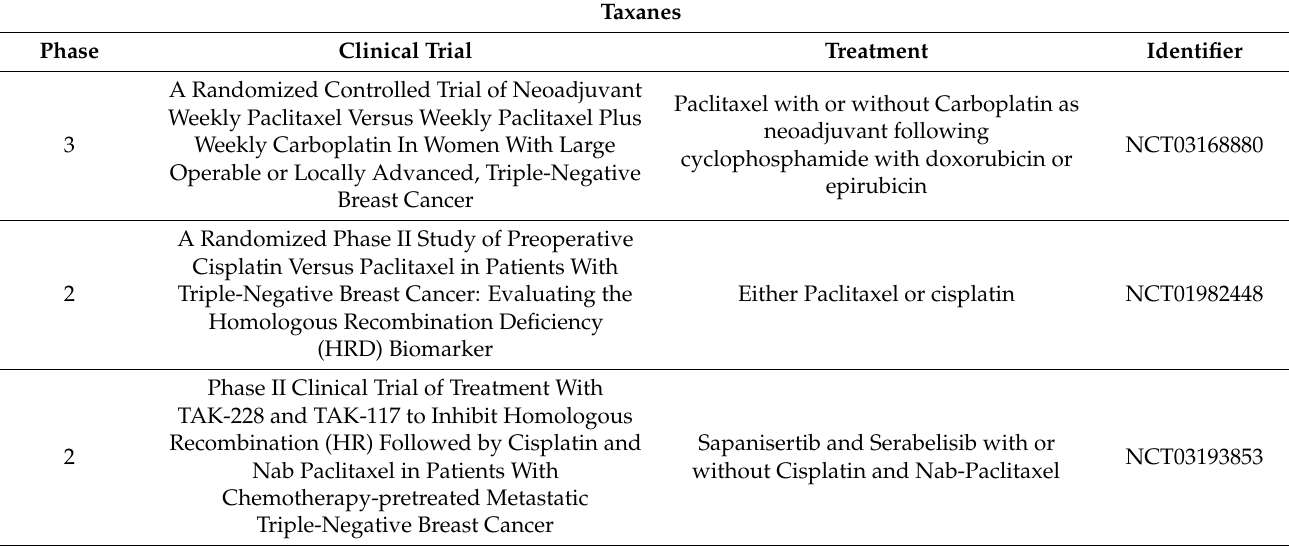
Table 1. List of active non-recruiting trials of combination therapy involving chemotherapy in